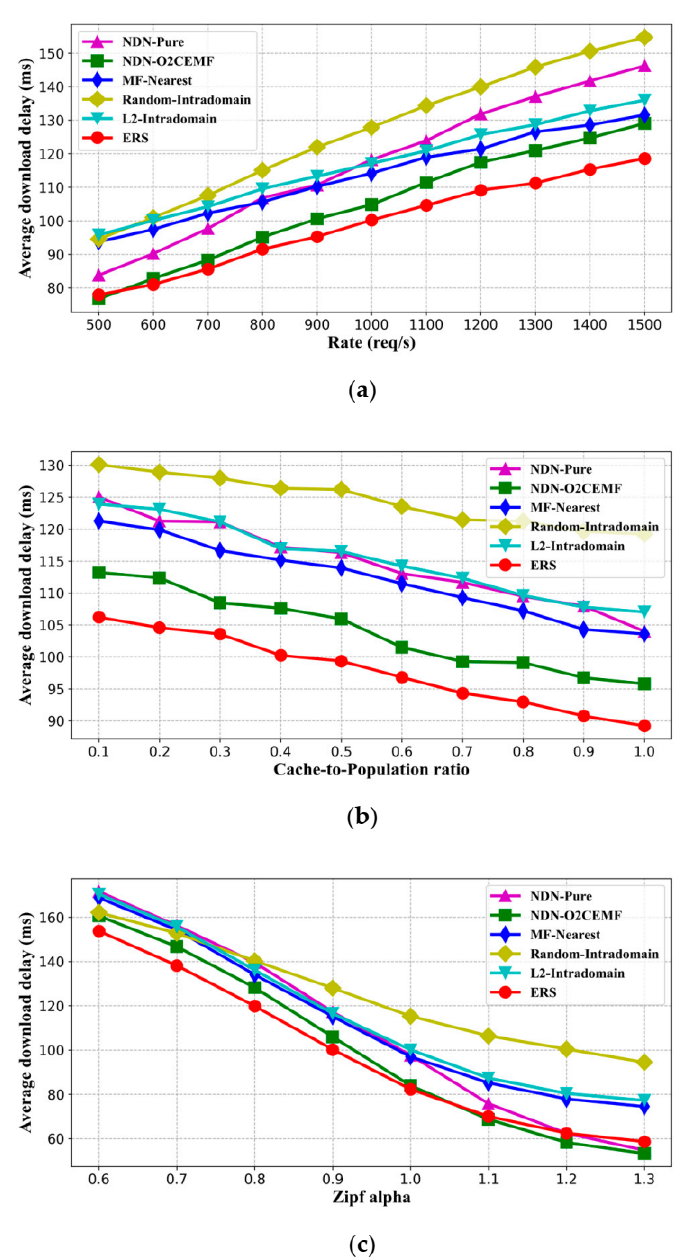
Figure 6. Average content download delay comparison with different impact factors. ( a ) Request rate, ( b ) cache-to-population ratio, and ( c ) Zipf parameter